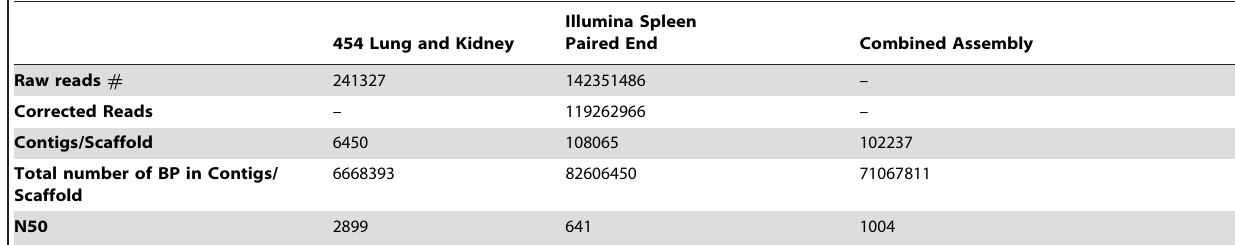
Table 1. Assembly statistics.